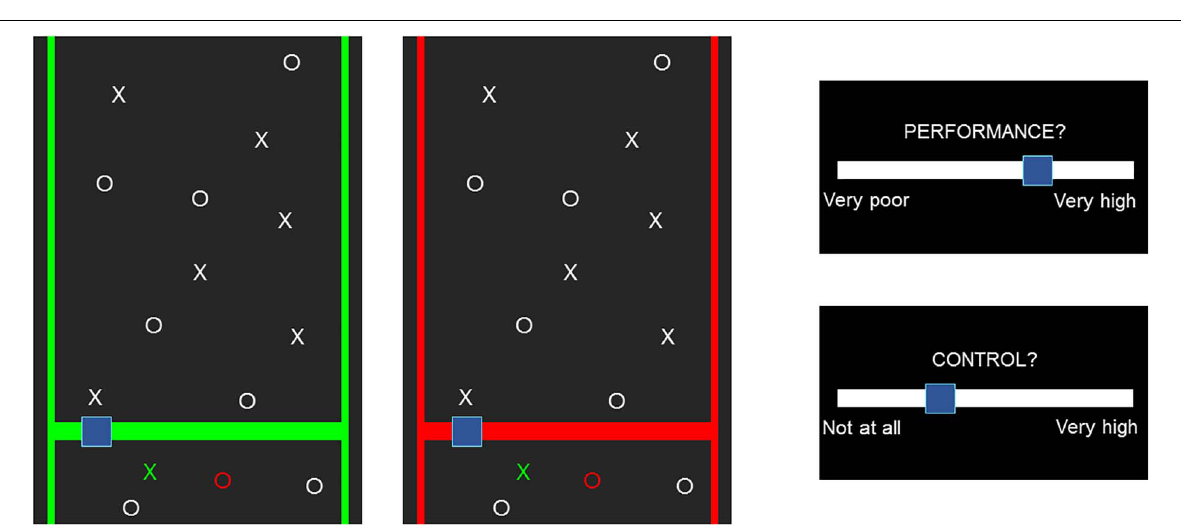
FIGURE 2 | The behavioral task. If the blue box hit the targets, they turned green, and if distractors were hit, they turned red. If not touched, targets and distractors remained white. After each round, participants were asked to rate their performance and sense of